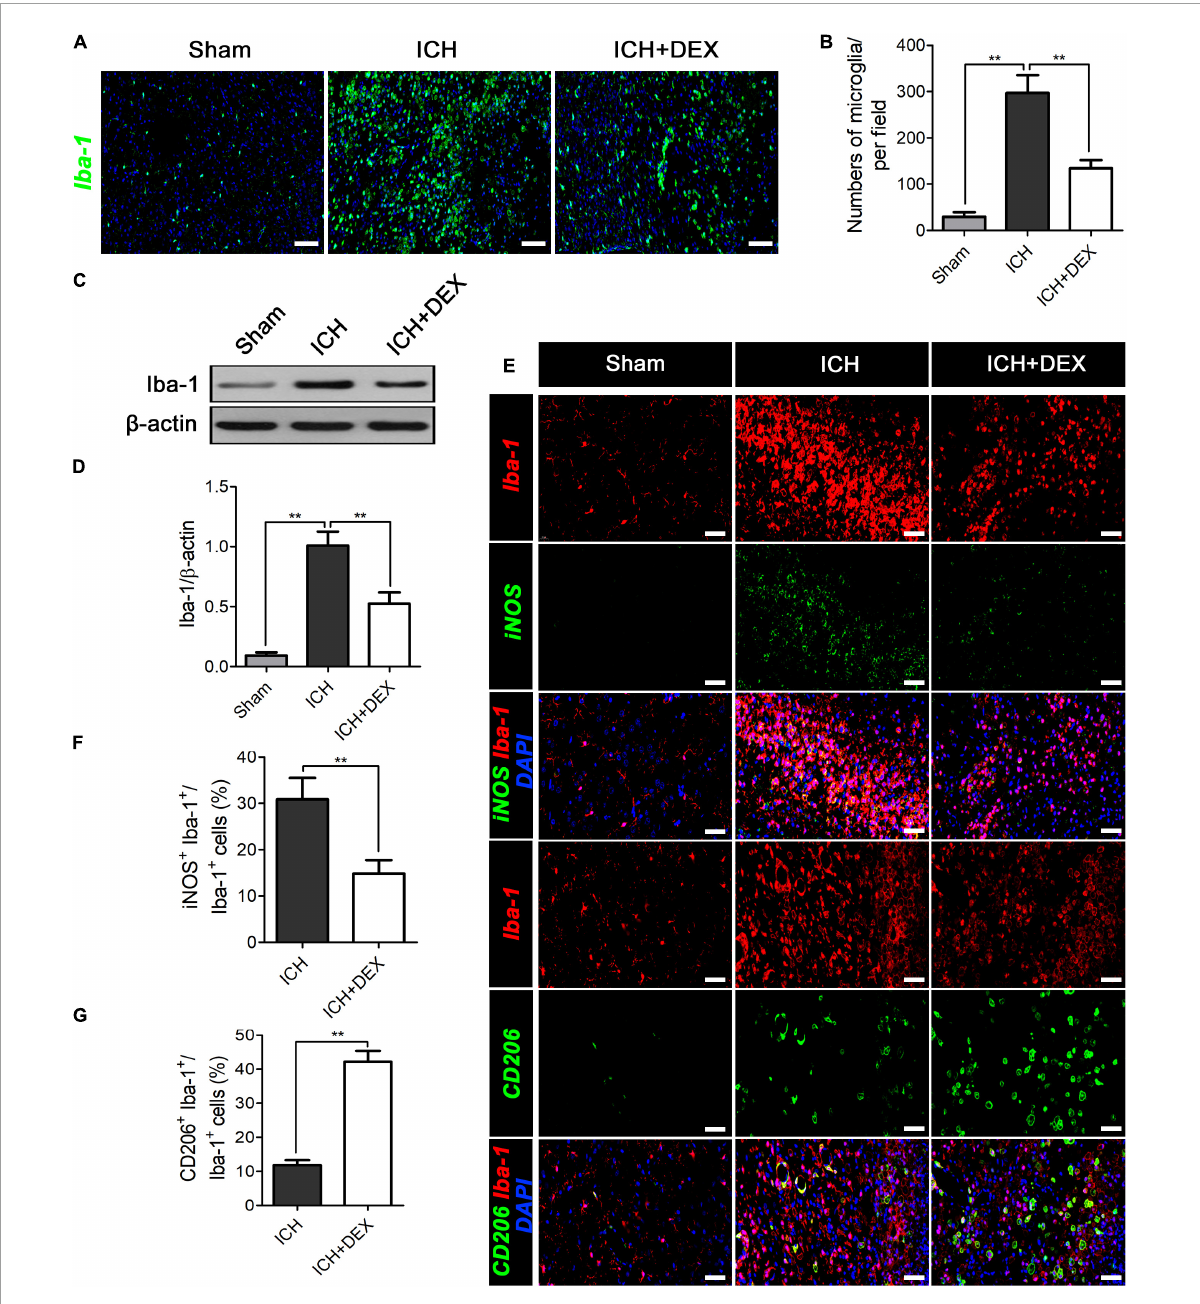
FIGURE4 On the 3rd-day post-ICH, (A,B) immunofluorescence revealed the DEX group significantly reduced the microglia/macrophage expression around hematomas compared with the ICH group. Scale bar = 100 µ m. (C) Representative Western blot expressions of Iba-1. (D) The expression of the Iba-1 protein was significantly upregulated in the ICH compared with the Sham group. However, treatment with DEX could notably suppress activated microglia/macrophage levels. (E,F) DEX reduced the ratio of Iba-1 + cells that co-expressed with M1-associated marker-iNOS. (E,G) The Iba-1 + cells that co-expressed with M2-associated marker-CD206 significantly increased in the DEX-treated group. ** p < 0.01. Scale bar = 50 µ